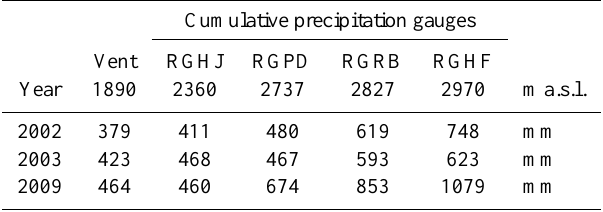
Table 2. Elevation and precipitation sums of the weather station Vent and the four cumulative precipitation gauges Hochjochhospiz (RGHJ), Proviantdepot (RGPD), Rofenberg (RGRB) and Hintere- isferner (RGHF) of the accumulation seasons ranging from the 1st of September to the 30 April.